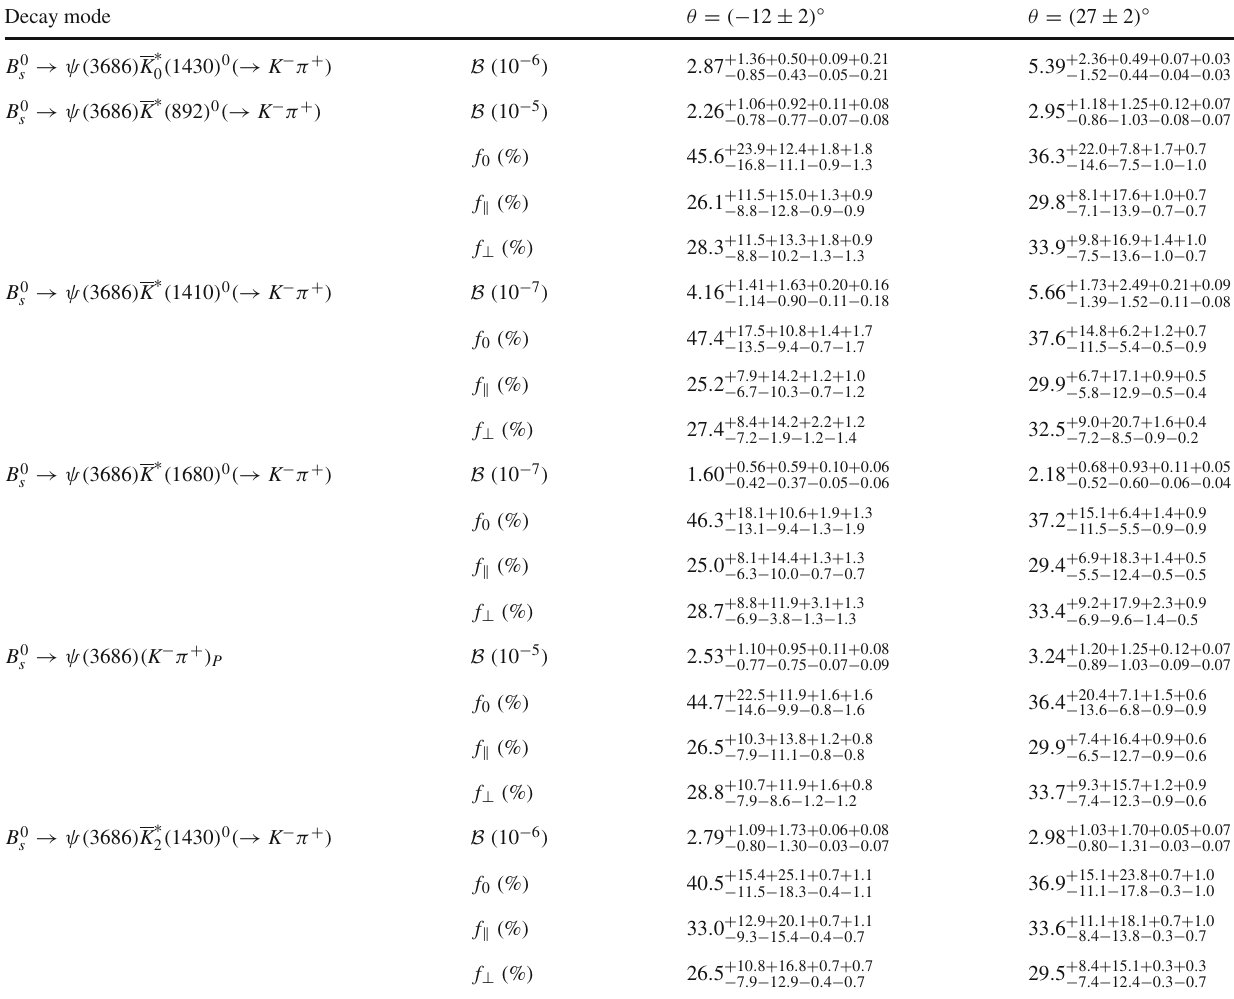
lated using the pQCD factorization approach. The first three uncertain- ties are derived from the uncertainties in the previous tables, whereas the last one is derived from the mixing angle